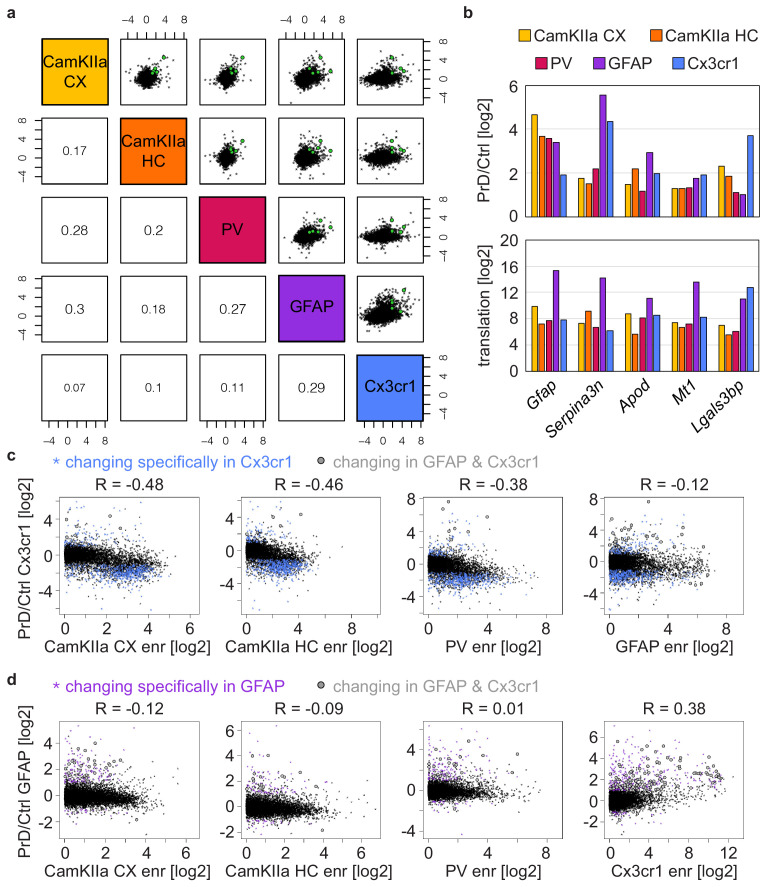
Identification of common and cell-type-specific translational changes.(a) Cross-correlation plot comparing prion-induced translational changes in different cell types. Pearson correlation coefficients are indicated. Genes that change in all five datasets are colored in grey. (b) Bars represent the translational change and the translation in the different cell types. Shown are genes that change in all five datasets. (c) Comparison of prion-induced translational changes in Cx3cr1+ cells vs the enrichment in the indicated cell type over Cx3cr1+ cells. Genes changing specifically in Cx3cr1+ cells or in both analyzed glia cell types are indicated. Genes that specifically decreased in Cx3cr1+ cells show an enrichment in neuronal cell types over Cx3cr1+ cells. (d) Comparison of prion-induced translational changes in GFAP+ cells vs the enrichment in the indicated cell type over GFAP+ cells. Genes changing specifically in GFAP+ cells or in both analyzed glia cell types are indicated. GFAP-specific changes are not enriched in any of the analyzed cell types.